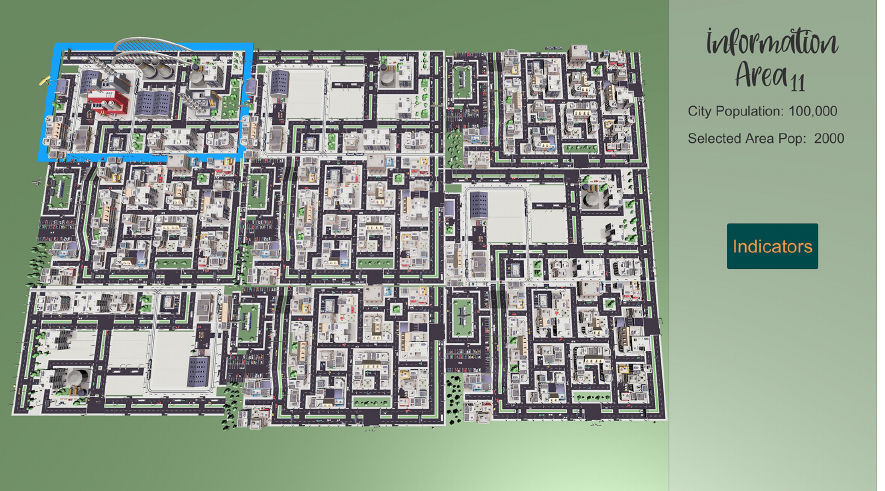
Figure 7. The Main Scene features a top-down view of the city, divided into nine parts. Each part can be highlighted, selected, and clicked to view information about waste management KPIs and policies in that